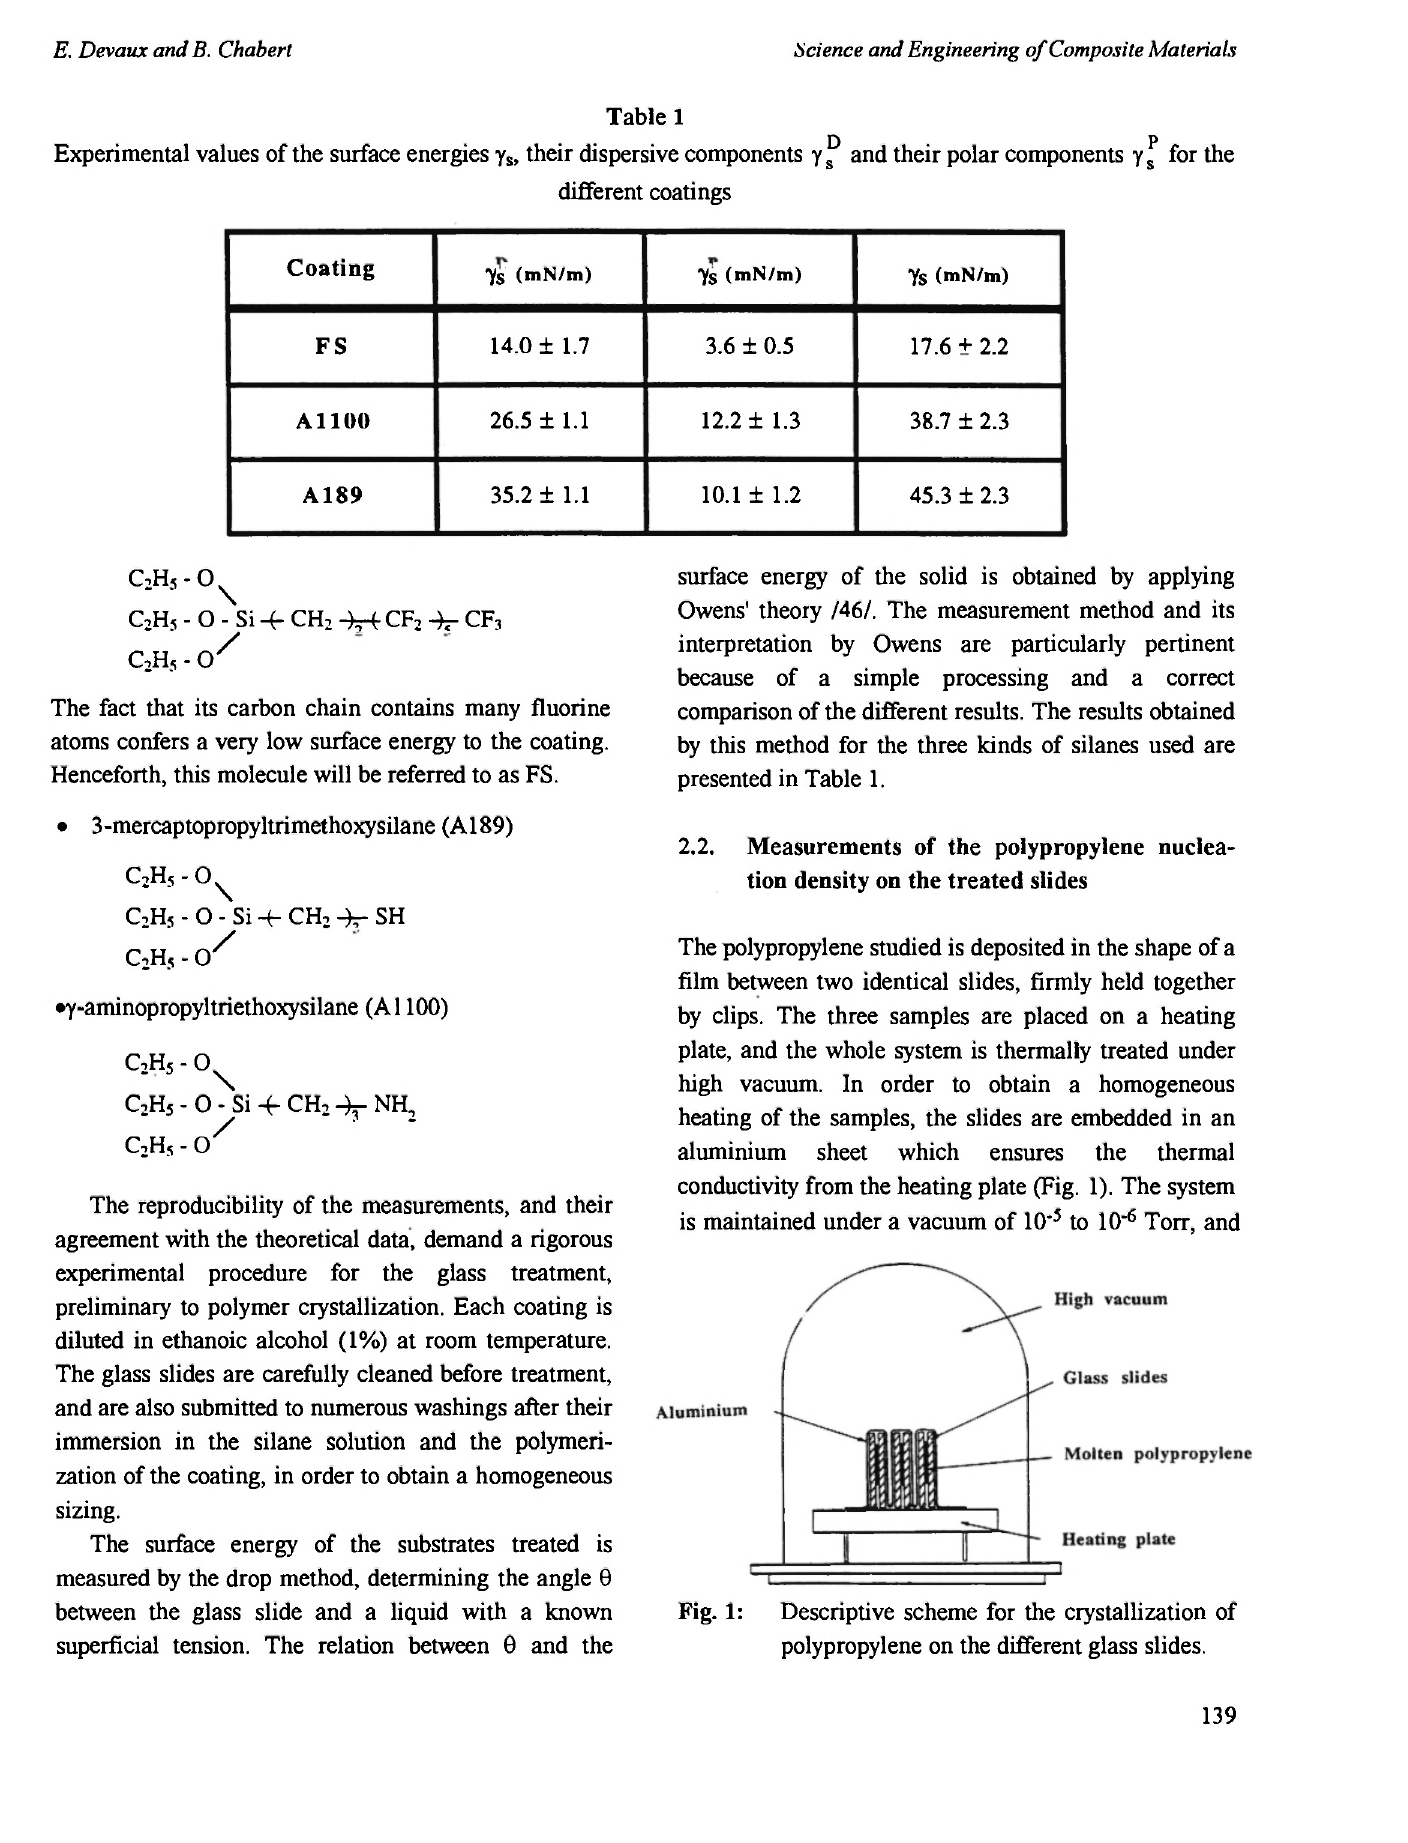
Experimental values of the surface energies y s , their dispersive components γ 8 and their polar components y s for the